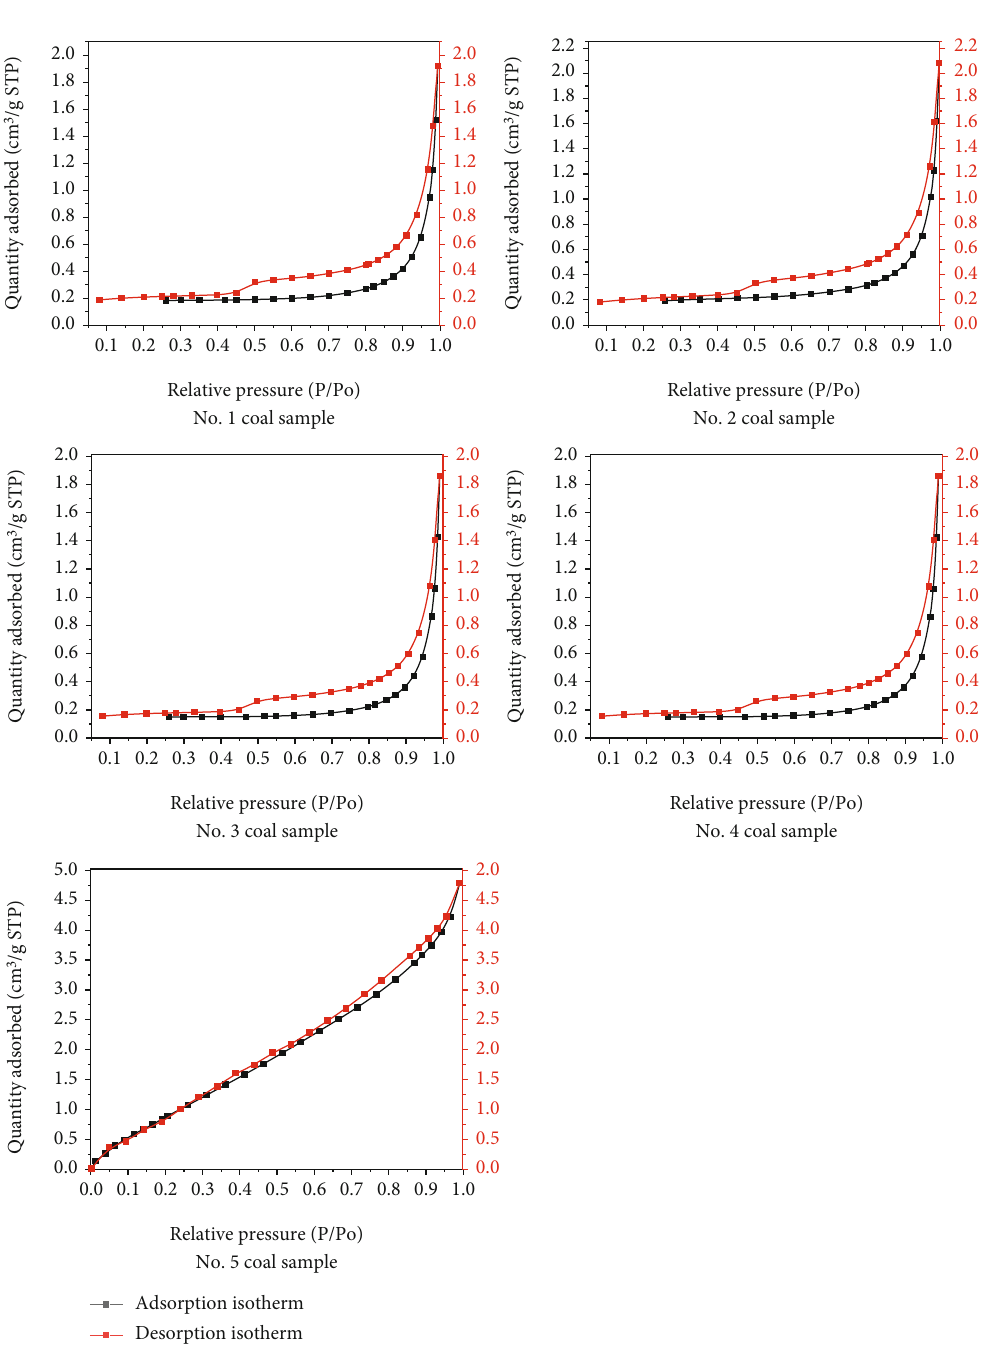
Figure 5: Adsorption isotherm of coal